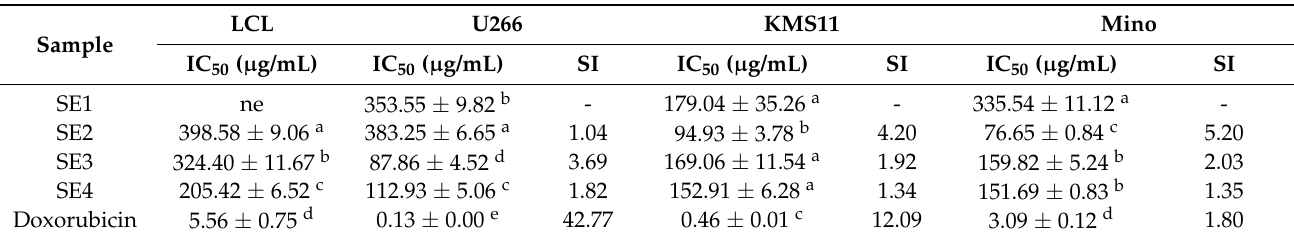
Table 3. Cytotoxic activities of fractions from SE extracts.